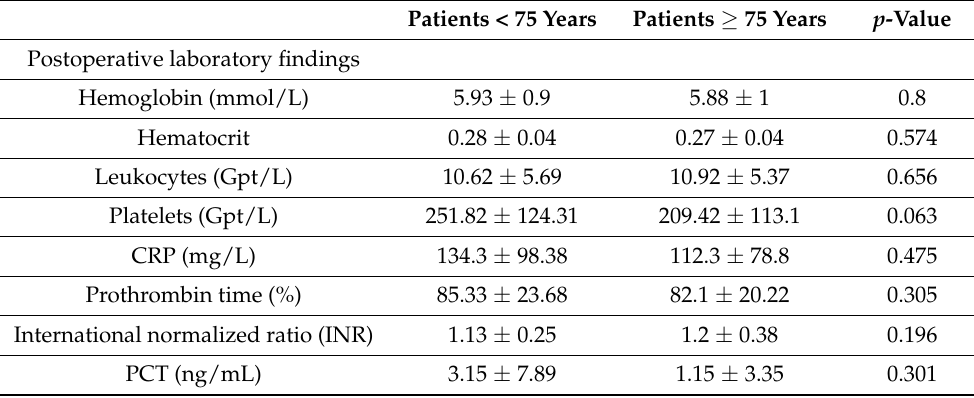
Table 3. Outcome and postoperative